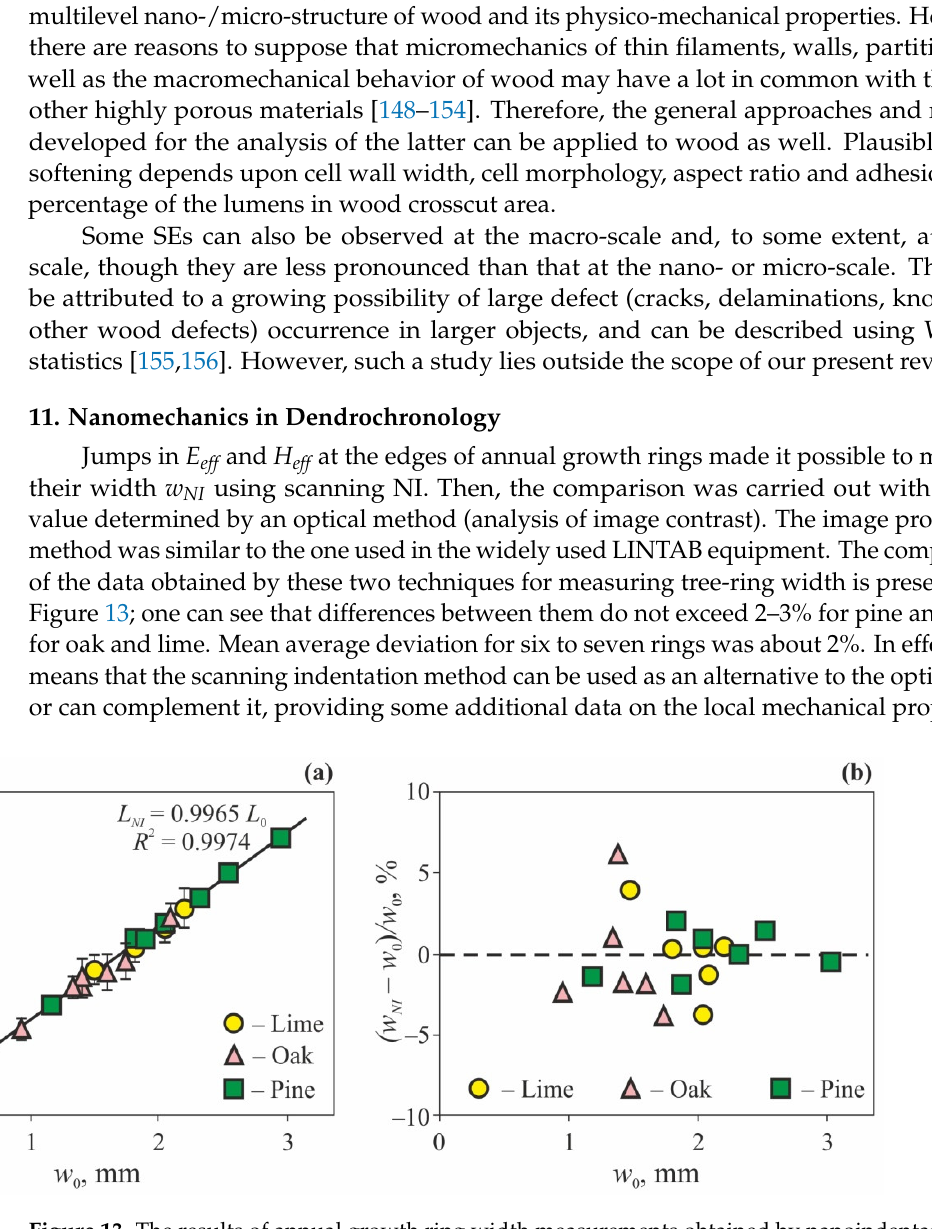
Figure 13. The results of annual growth ring width measurements obtained by nanoindentation w NI and by the optical method w 0 ( a ), and the discrepancies between these methods ( b )